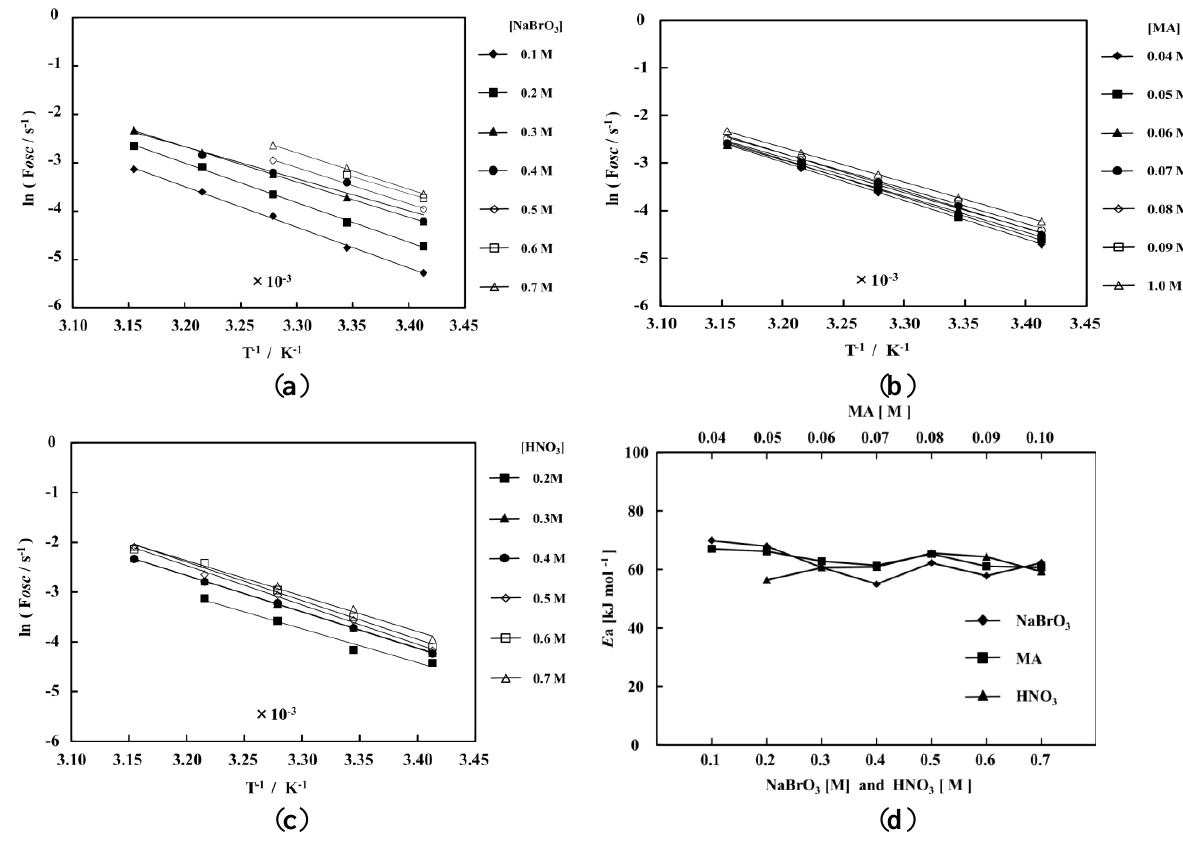
Figure 9. Arrhenius dependence of oscillating frequency, F osc , on temperature for different concentrations of one BZ substrate under fixed concentrations of the other two BZ substrates: ( a ) [MA] = 0.1 M and [HNO ] = 0.3 M, ( b ) [NaBrO ] = 0.3 M and 3 3 [HNO ] = 0.3 M, and ( c ) [NaBrO ] = 0.3 M and [MA] = 0.1 M. ( d ) Dependence of 3 3 activation energy on concentrations of the three BZ